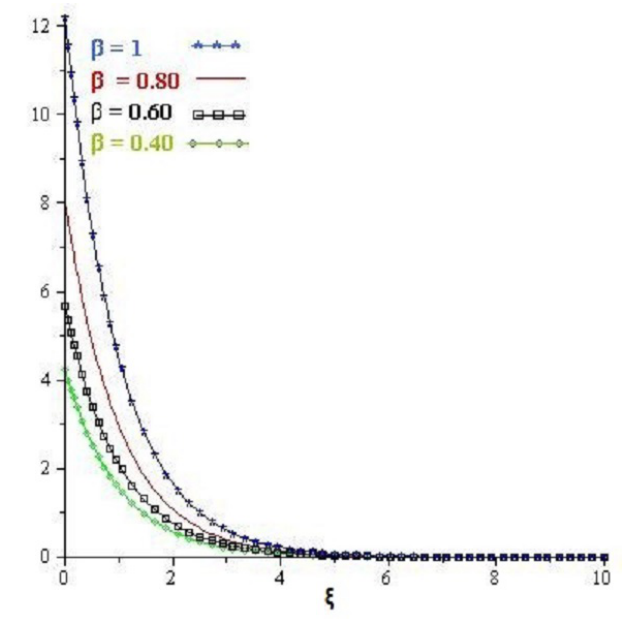
Figure 6. Variational homotopy perturbation transform method solution of example 4.3 at different fractional order β = 1, 0.8, 0.6,